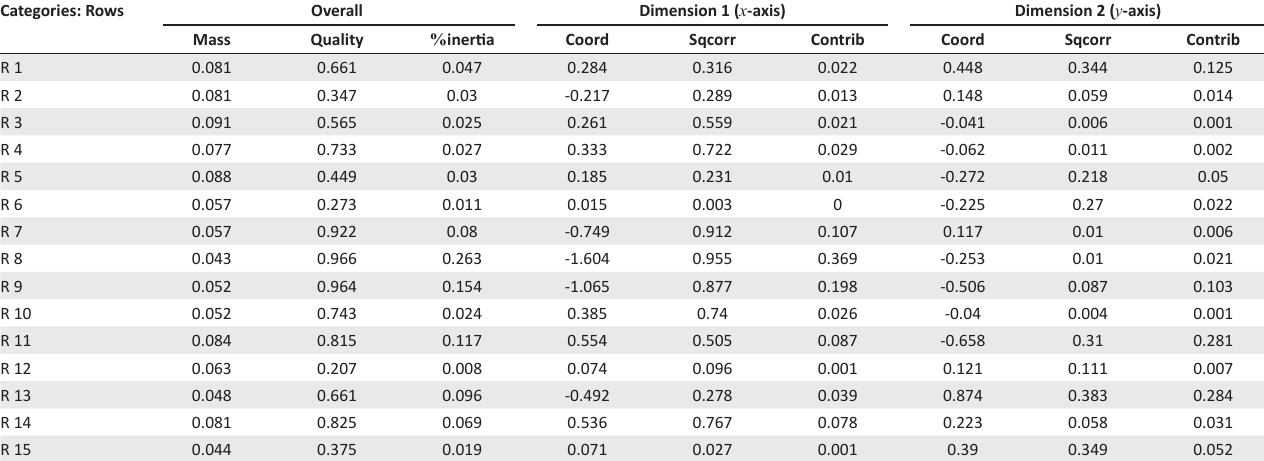
Table 1-A2 represents the statistics relating to the characteristics of the goodwill (rows) in the correspondence table. Each characteristic has a coordinate in both Dimension 1 and Dimension 2, with the contribution (‘contrib’) showing the relative strength of the characteristics in the overall relationship. A higher contribution indicates a greater strength and, therefore, increasing statistical significance. TABLE 1-A2: Statistics for characteristics of